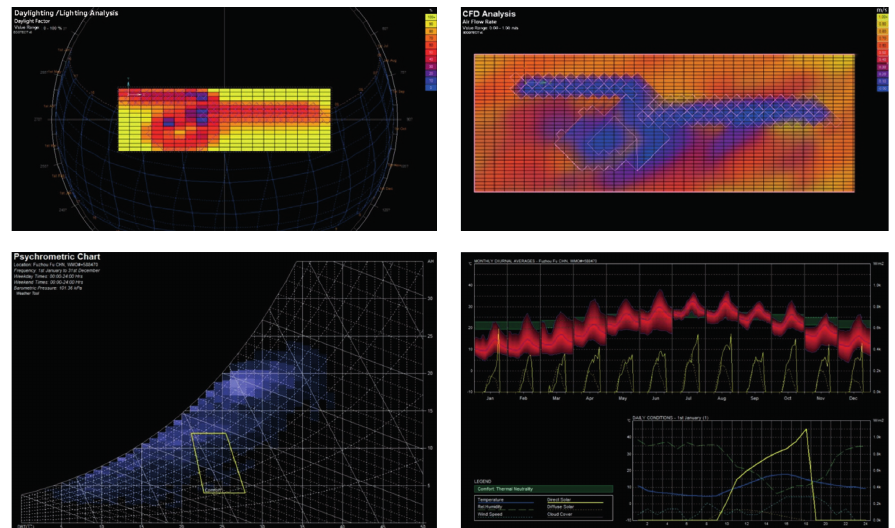
Figure 8: Photo of pilot projects. (a) Container modular fire station under construction. (b) Photo of “Xiangyu” Residence in Yangzhou Software Park. (c) Indoor photo of the container pilot project. (d) Photo of Yangzhou Suburb Park Maker Center.